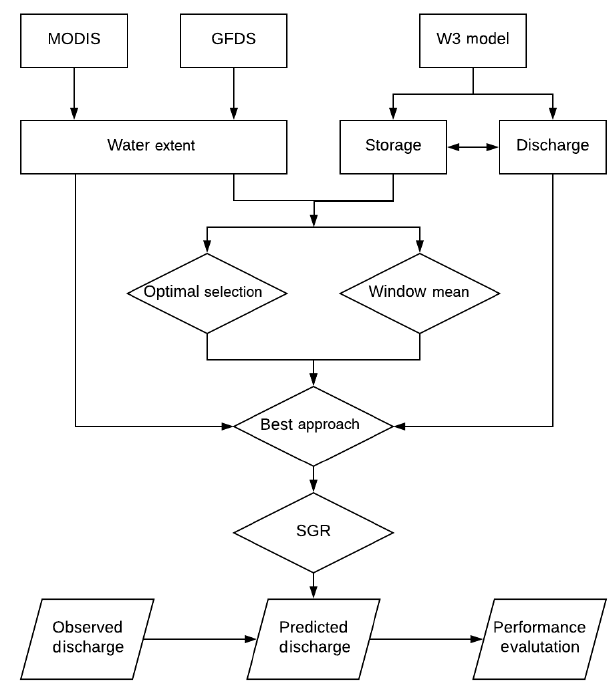
Figure 1. Workflow of the overall methodology (rectangle: data; diamond: method; parallelogram: